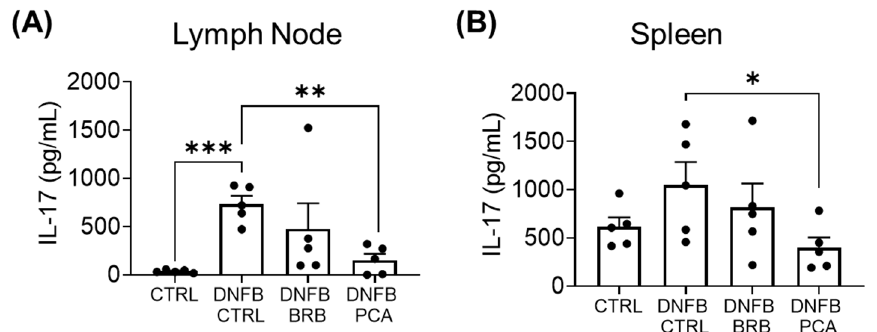
Figure6. Il-17productionissignificantlyreducedbyPCAsupplementeddiet, butnotBRBsupplemented diet. ( A , B ) IL-17 production (pg / mL) by CD3 stimulated cells isolated from the ( A ) draining lymph nodes and ( B ) spleens of experimental mice. * p -value < 0.05; ** p -value < 0.01; *** p -value < 0.005 for comparisons between DNFB-challenged mice fed control diets and comparison groups using Student’s t test.